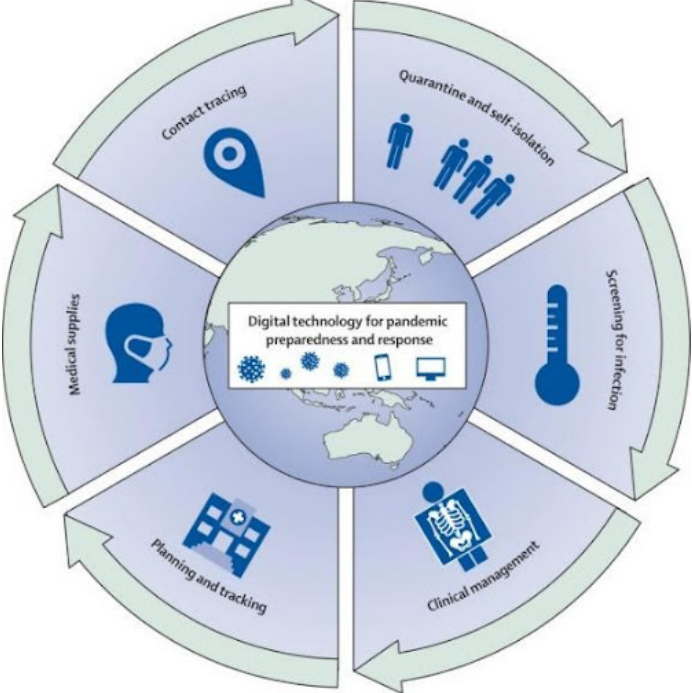
Figure 4. Digital tools for pandemic preparedness and response